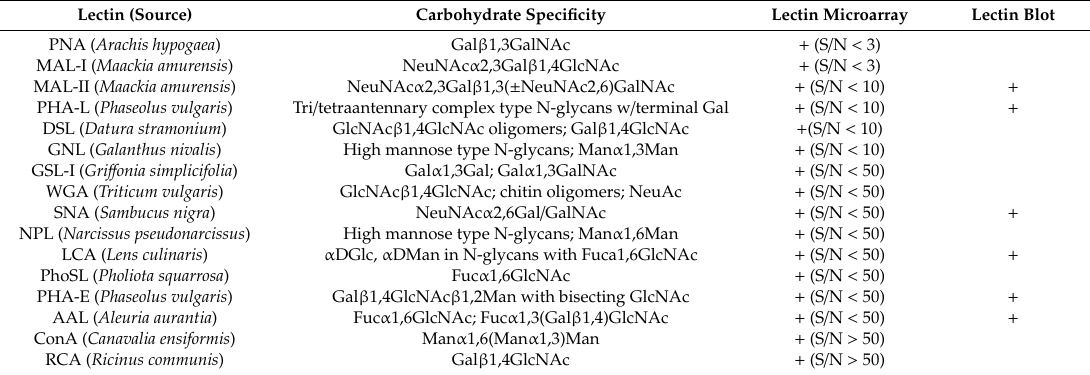
Table 3. Carbohydrate specificities of lectins employed in the lectin-based microarray and lectin blot. Lectins used in each method are marked with “ + ”. For the lectin-based microarray, the obtained S / N ratios are given in